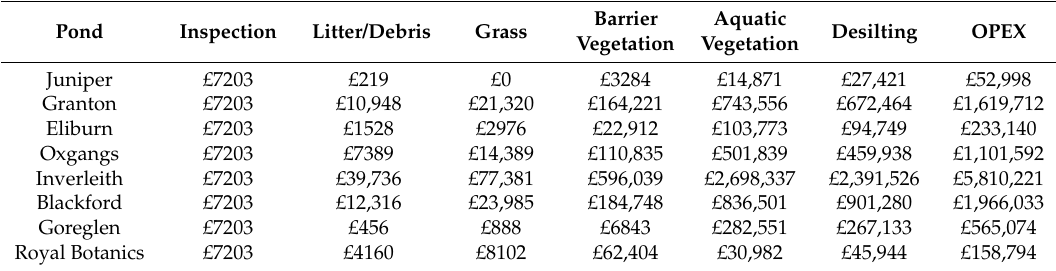
Table A1. Outlining costs for Whole Life Cost (WLC) analysis (based on UK Water Industry Research (UKWIR) 2005 & cited in [16,27]). Costs are grouped together for barrier vegetation, aquatic vegetation and Desilting (which includes silt mobilisation and removal) OPEX outlines the total cost for operation and maintenance during the project life (50